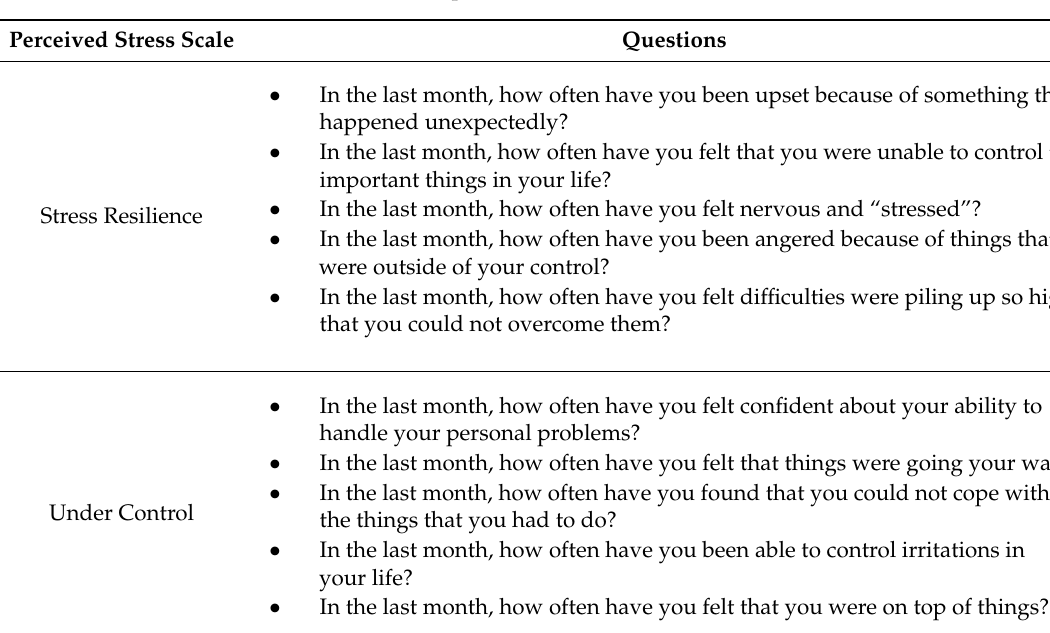
Table A2. Components of Perceived Stress